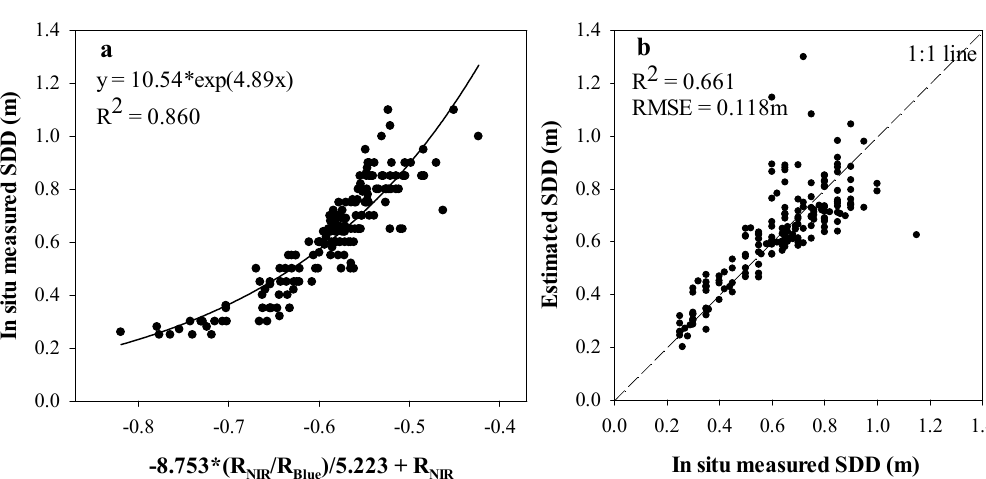
R Blue and R NIR represent the atmospherically corrected reflectance values of the blue band and near- infrared band in the Landsat images respectively. The best fit algorithm is shown in bold.